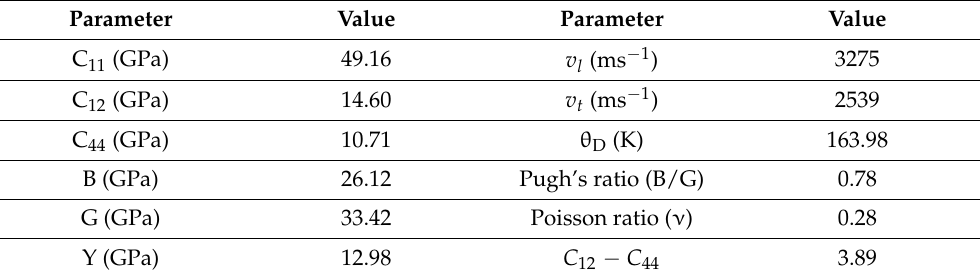
Table 1. Computed elastic parameters of SrBaSn compound at equilibrium lattice